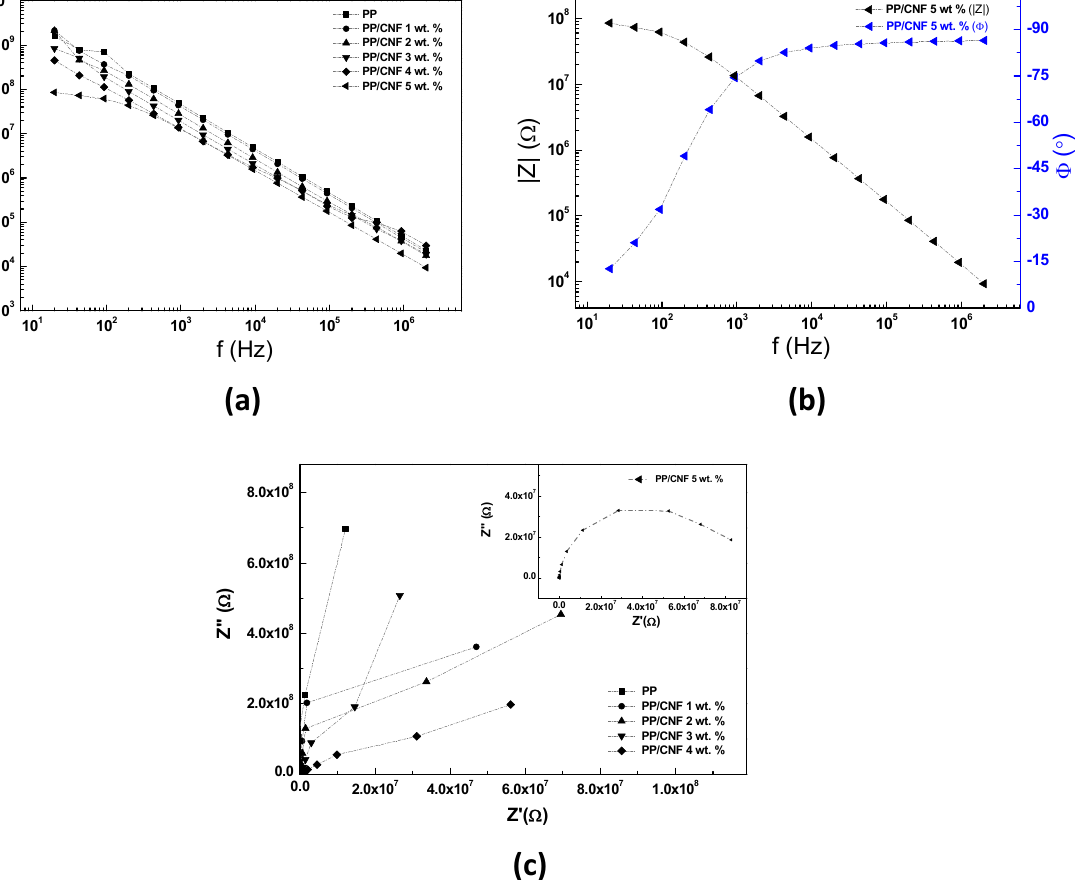
Figure 8. Dependence on frequency of electrical impedance in PP/CNF composites. Modulus | Z | of PP/CNF composites ( a ) Bode plot of PP/CNF 5 wt. % composite ( b ) Nyquist plots of PP/CNF composites ( c ).